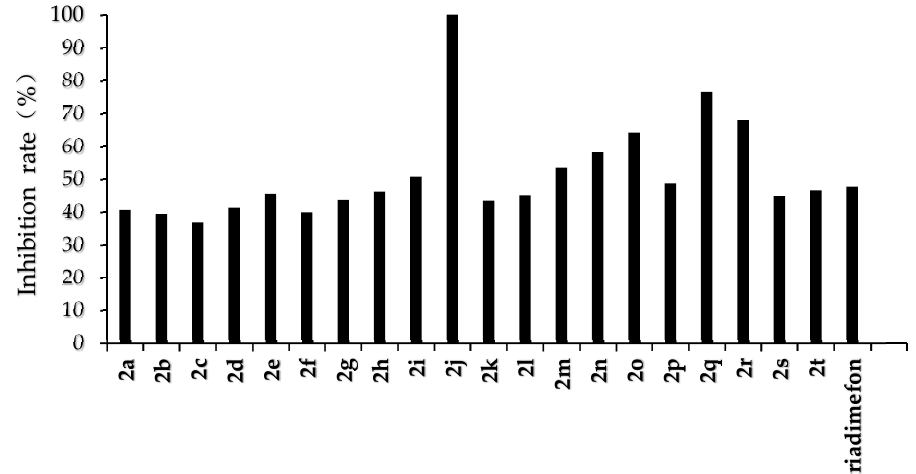
Figure 3. Antifungal activity of the target compounds ( 2a – 2t ) against F. graminearum .